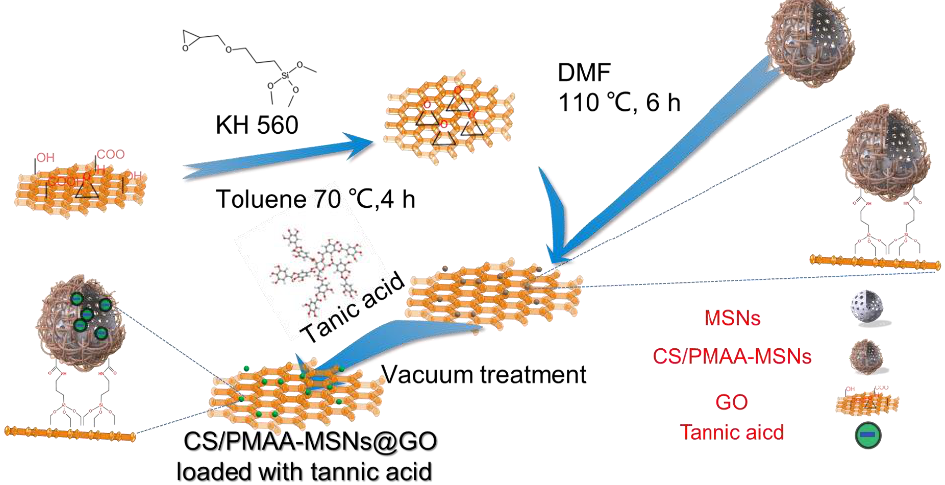
Figure 4. Synthesis mechanism of graphene oxide (GO) grafted functional silica nanoparticles loaded with tannic acid.